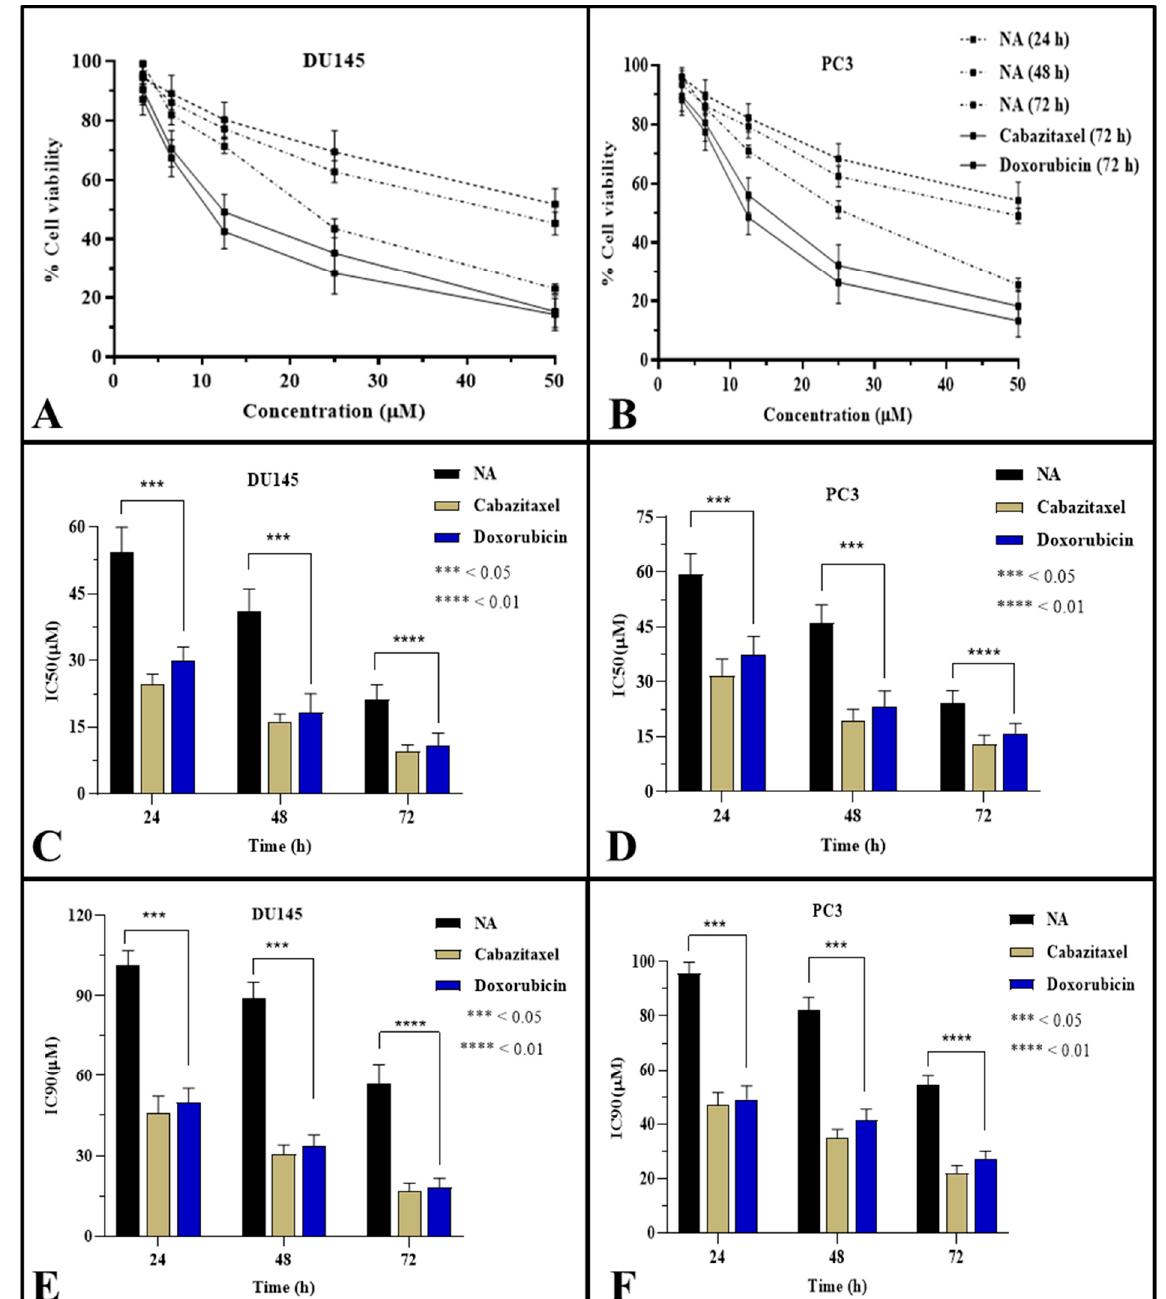
Figure 2. Effect of NA on the viability of prostate cancer cells and IC 50 values. Note: MTT assay was used to determine the viability of cancer cells. ( A ) 24, 48, and 72 h treatment of DU145 cells and ( B ) 24, 48, and 72 h treatment of PC3 cells. ( C ) IC 50 values of NA against DU145. ( D ) IC 50 values of NA against PC3. ( E ) IC 90 values of NA against DU145. ( F ) IC 90 values of NA against PC3. Data are mean ± SEM of % cell viability ( n = 3) at p < 0.05 and p < 0.01.